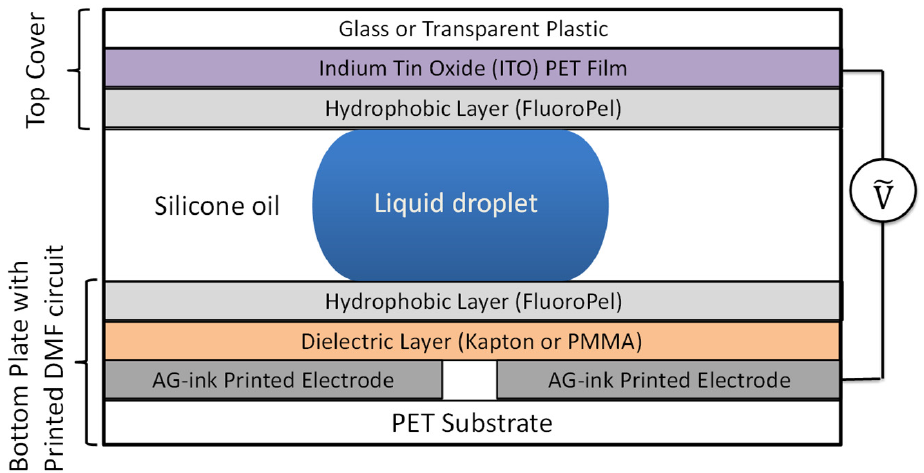
Figure 1. Conceptual diagram showing the assembly layers of the DMF cartridge with Ag-ink-printed electrodes. The schematic is not drawn to scale.